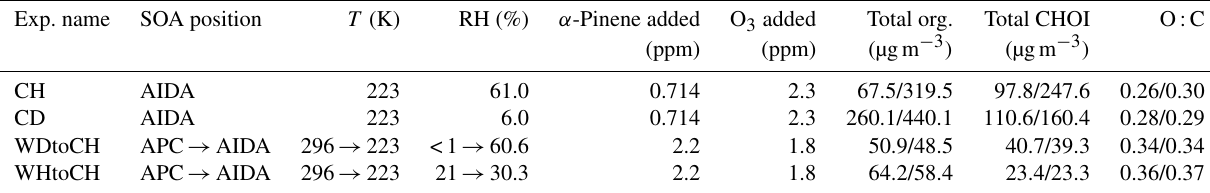
Table 1. Experimental conditions and precursor concentrations for the four experiments discussed in this study: CH and CD (type 1); WDtoCH and WHtoCH (type 2). Total organic mass (Total org.), CHOI mass concentrations, and elemental oxygen to carbon (O:C) ratios are given for t 0 and t 1. RH values (with respect to water) from the APC chamber were measured at room temperature